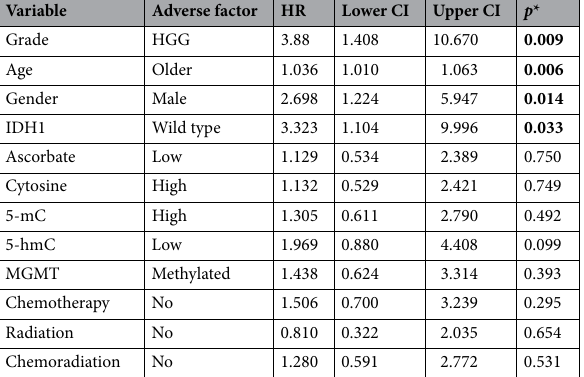
Table 3. Univariate analysis of survival of patients with glioma in cohort. HR, hazard ratio; CI, 95% confidence interval. * p -values were derived from the Cox regression model, statistical significance p < 0.05 in